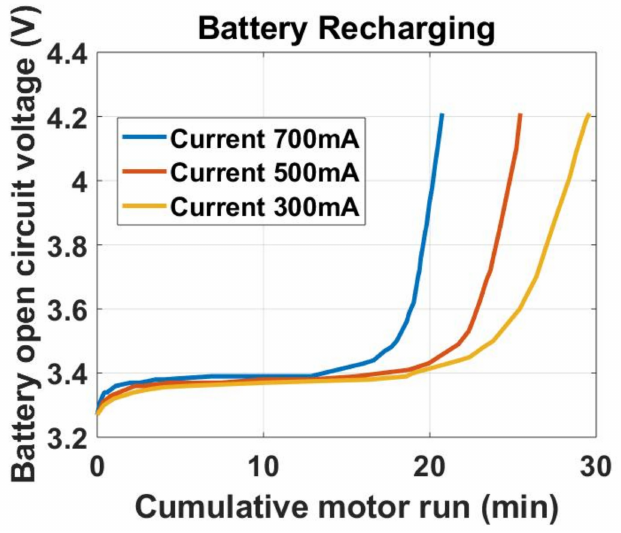
Figure 14. Battery open circuit voltage for one cell during recharging with different charging